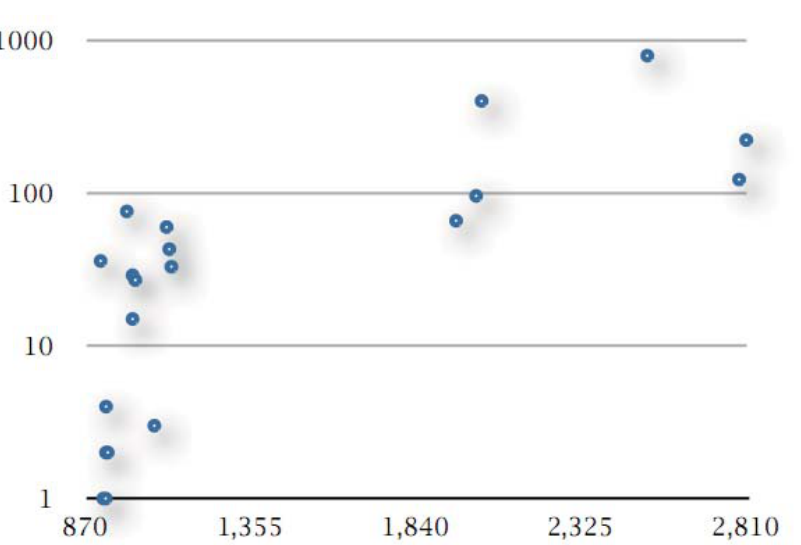
Figure 3. Correlation between genome size and unique genes. Genome size is given as the number of protein-coding genes (shown on the x-axis) against the count of unique genes (number of unique genes without homologs within the pangenome, shown on the y-axis; y-axis is displayed on logarithmic scale). The six points on the upper right part of the graph are evidently those genomes with largest gene counts, all outside the Chlamydiaceae family (see Table 1 and text). The pattern observed is primarily due to the sampling of taxonomic space of the Chlamydiales and will vary as more genomes from this group become